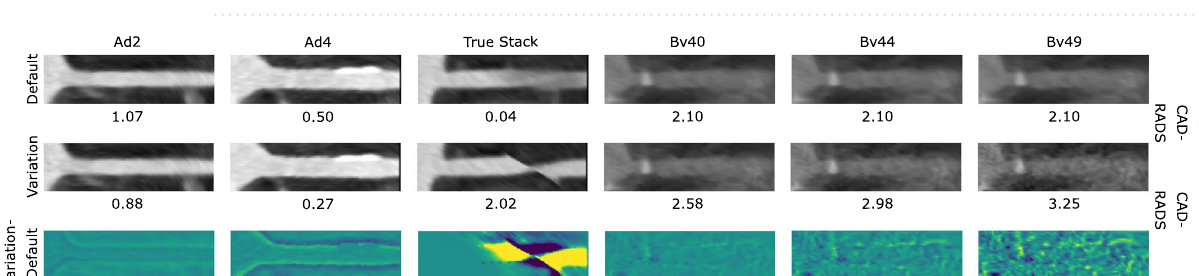
Figure 5. Number of samples for which the class prediction changed due to the parameter change (abbreviations as in Fig. 3). Total class changes refers to all CAD-RADS grades, RO to the rule-out and HO to the hold-out task. Note: predictions close to the thresholds easily change class bin even with small prediction changes.